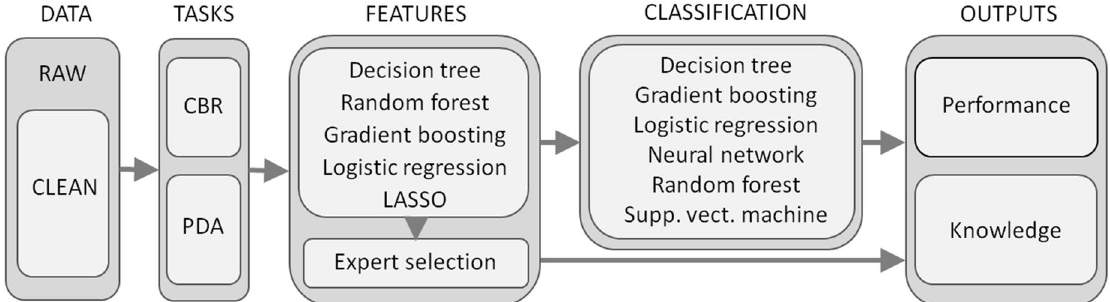
Figure 1. An outsketch of the methodological process used in the analysis. After cleaning the data, the problem was solved in two parallel tasks (CBR and PDA). Using several feature selection methods followed by expert evaluation, the most important predictors of active VS treatment were identified. The identified set of predictors was processed by several classification methods to create models capable of predicting the active VS treatment based on the predictor values. The performance of the models was analyzed using various performance